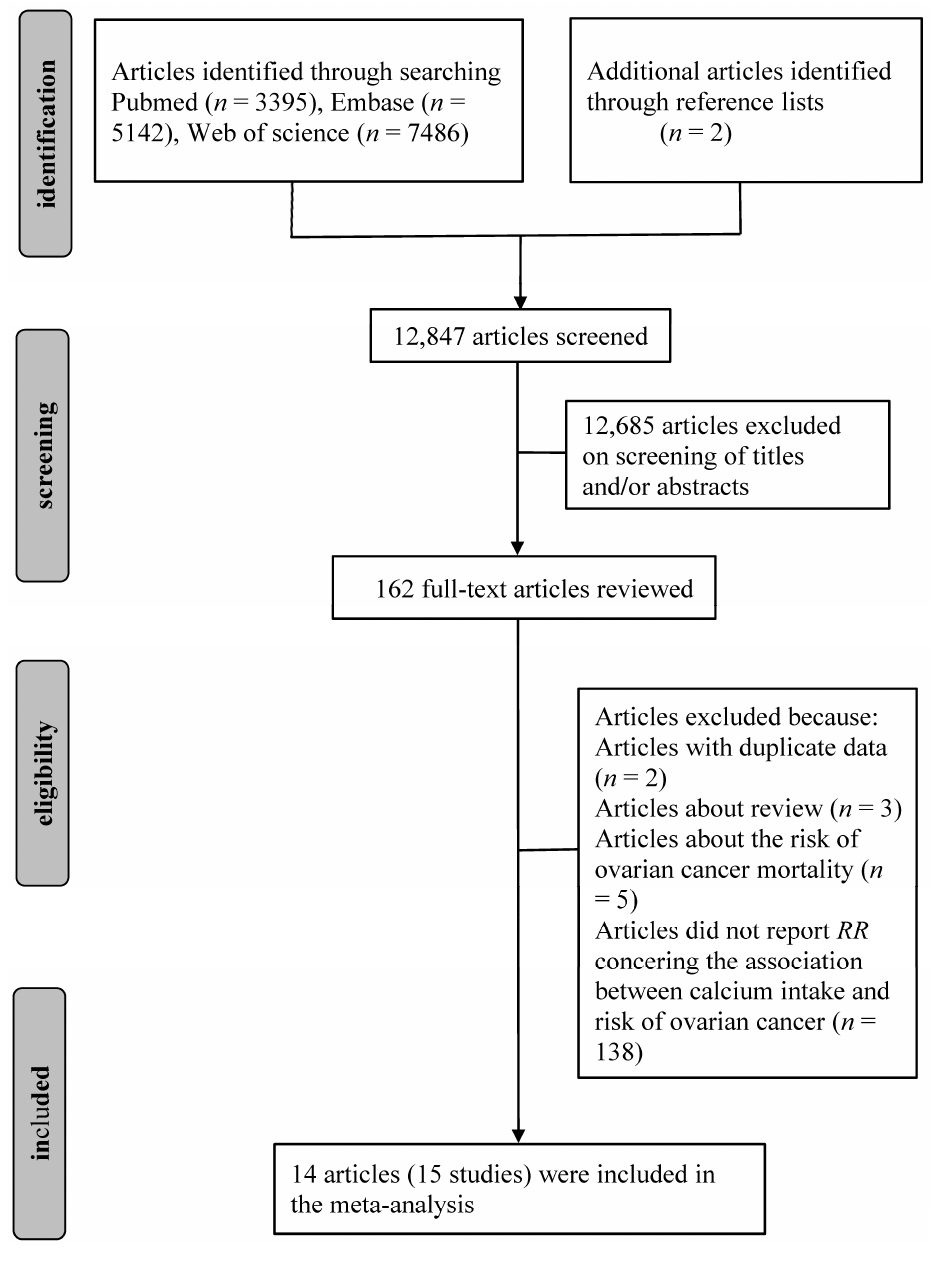
Figure 1. Flowchart of the selection of studies included in the meta-analysis.